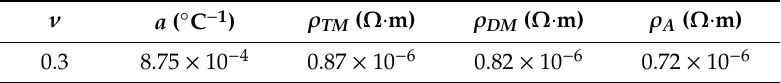
Table 2. Electrical parameters of the